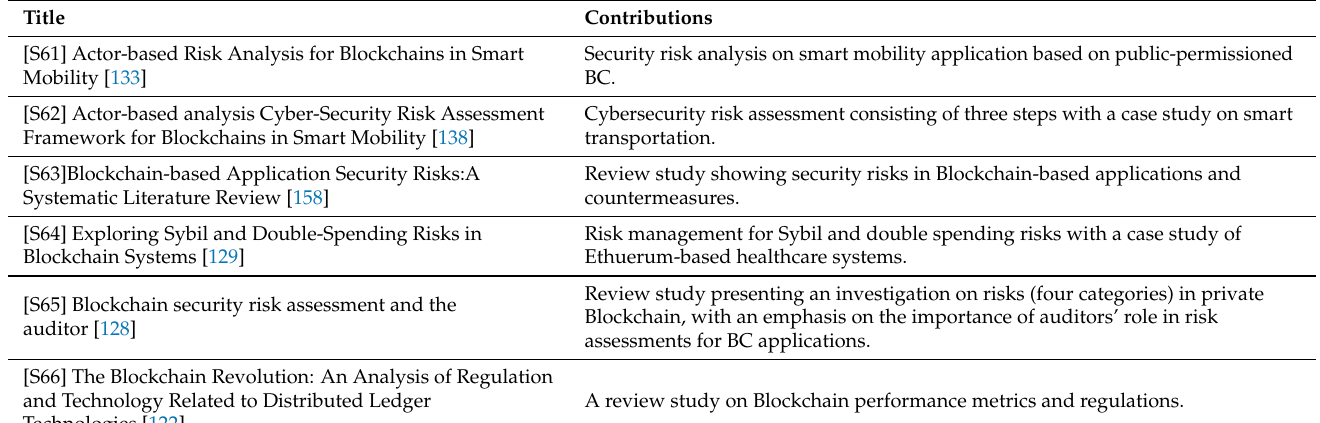
Table A3. Contributions of BC security risk